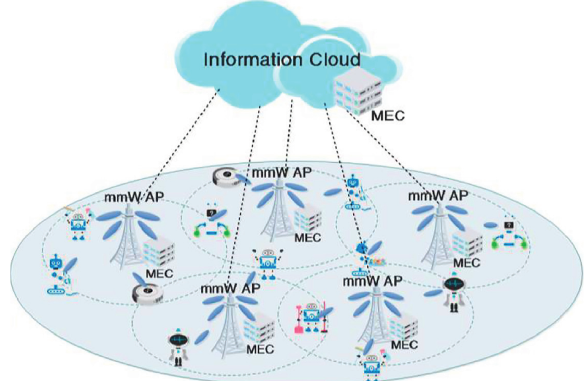
Figure 1: The network framework for mobile robots in MEC